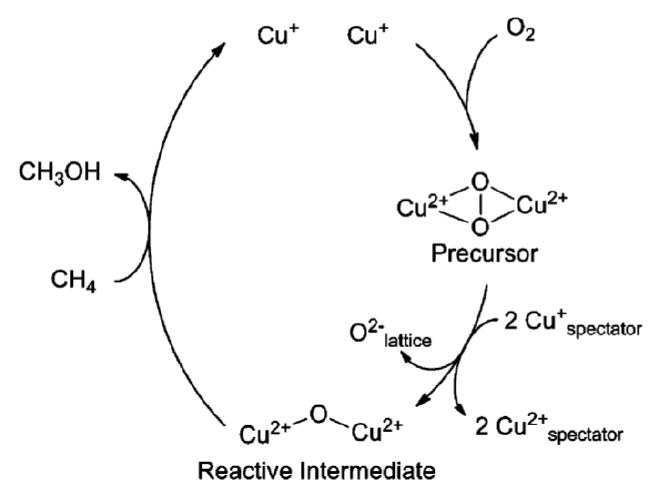
Figure 4. Schematic illustration of the catalytic sites in Cu-ZSM-5 catalyst during the oxidation of methane to methanol. Reproduced with permission from ref. [46]. Copyright 2010, American Chemical Society.